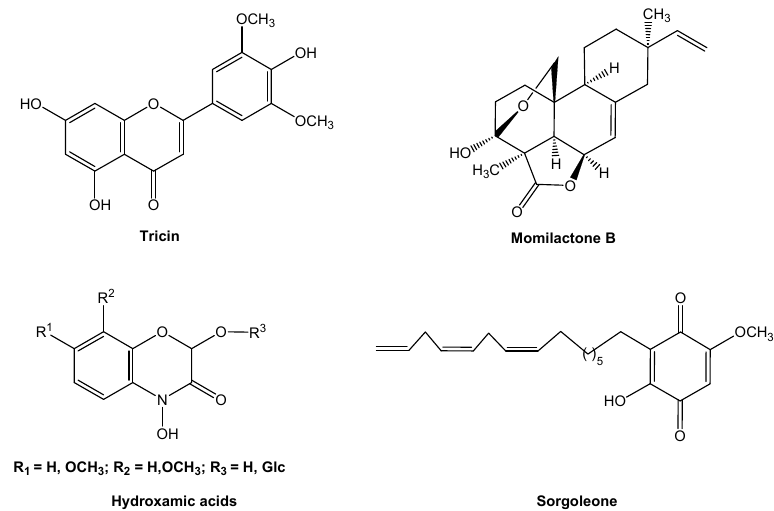
Figure 3. The key allelochemicals involved in the principal grain crops.